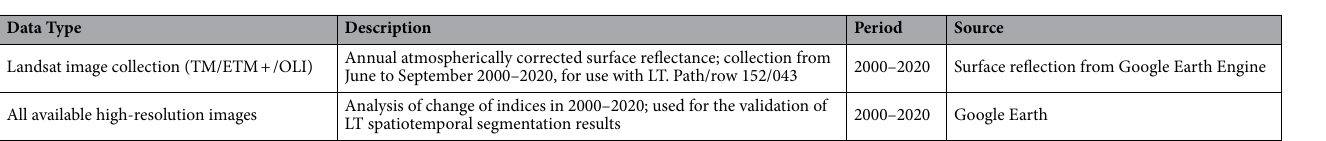
Table 2. Data type, description, and source in this